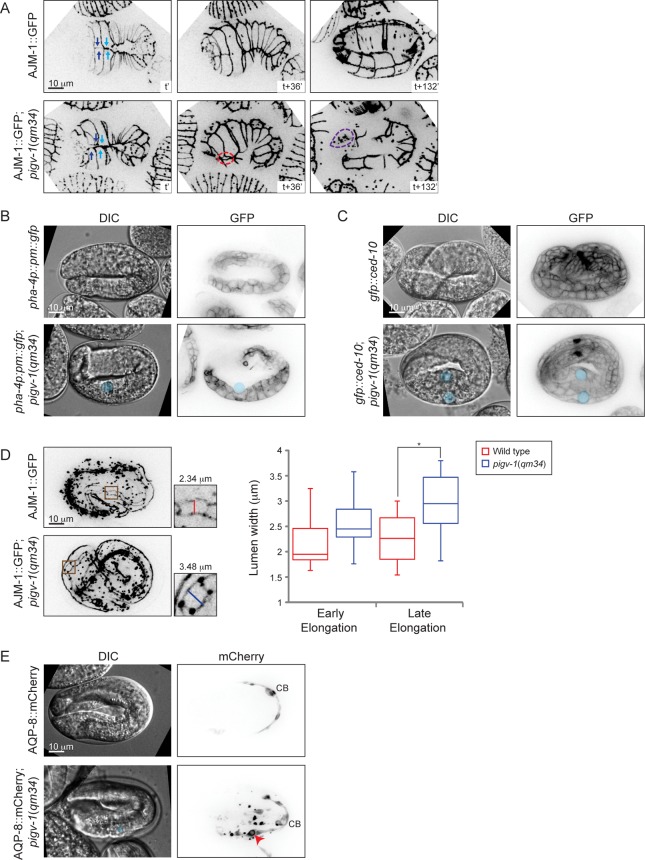
Loss of GPI-APs leads to breaches in epithelial tissue in the embryonic epidermis, intestine and excretory canal.(A) Epidermal cell sealing at the embryo ventral midline is defective in pigv-1(qm34) mutant. In wild type embryo, the two pairs of leader cells coming from left and right sides of the embryo perfectly align at the embryo midline (top left panel), leading to embryo enclosure (top middle panel) and followed by successful elongation (top right panel). In pigv-1(qm34) mutant, two pairs of ventral epidermal leader cells misalign at embryo midline (bottom left panel). As a result, a gap is formed between the leader cells (bottom middle panel) and subsequently cells are bursting out from the hole (bottom right panel). See the corresponding movies S1 Movie and S2 Movie. Cell junction in all panels is marked by AJM-1::GFP. A maximum intensity projection of embryo epidermis is shown in all panels. Light and dark blue arrows indicate two pairs of leader epidermal cells, stippled red circle indicates gap between leader cells and stippled magenta circle indicates location of rupture. (B) Cysts form at intestine basal side in pigv-1(qm34) embryo. Blue circle indicate cyst location in both DIC and GFP panels. (C) Cysts are located in between intestine and basal lamina in pigv-1(qm34) embryo. Blue circles indicate cyst location in both DIC and GFP channels. (D) Intestinal lumen is enlarged in pigv-1(qm34) embryo. Wild type and pigv-1(qm34) embryos expressing AJM-1::GFP and undergoing elongation were fixed. A maximum intensity projection of embryo intestine was made and the widest section of intestine both in wild type and in pigv-1(qm34) embryos were measured (inset). The graph shows lumen width in wild type and pigv-1(qm34) embryos at early elongation (2 and 2.5 folds), as well as late elongation (3 and 3.5 folds). The line inside the box indicates median, whereas the whiskers indicate minimum and maximum values. Lumen width in pigv-1(qm34) embryo is significantly wider than that of wild type at late elongation (n > 7 for each data set, *P <0.05, two-tailed test) (E) Cyst forms in excretory canal of pigv-1(qm34) embryo. Excretory canal is marked by AQP-8::mCherry. Blue circle indicates cyst location in DIC channel, red arrowhead indicates cyst location in mCherry channel and CB stands for cell body. A maximum intensity projection of the excretory canal is shown in mCherry channels.